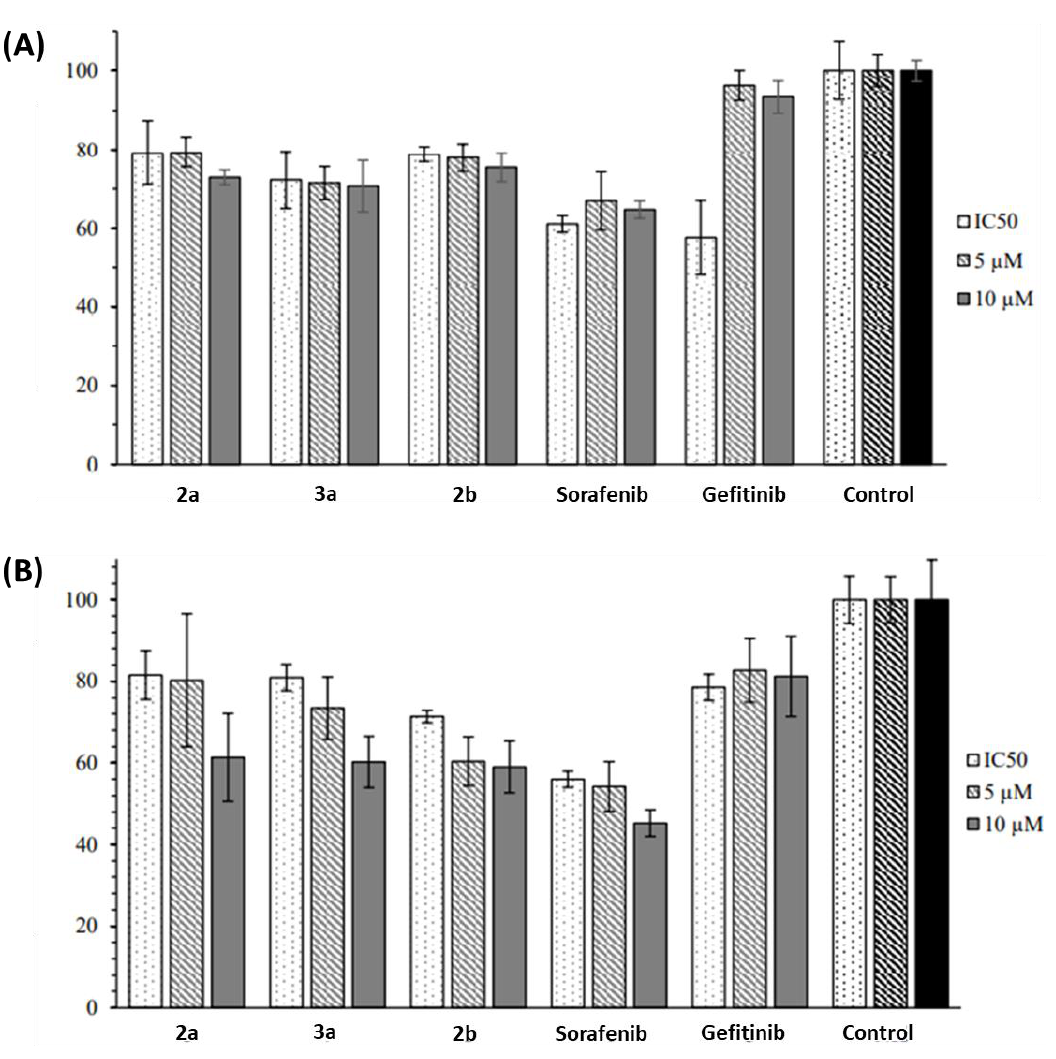
Figure 8. Suppression of tumor spheroids by 2a , 2b and 3a in HCT-116 wildtype cells ( A ); and HCT-116 p53-knockout cells ( B ). Sorafenib and gefitinib (50 µ M in the wildtype cells) were used as positive controls. y-axis: spheroid diameter in % with control set to 100%. n = 3 ± SD.